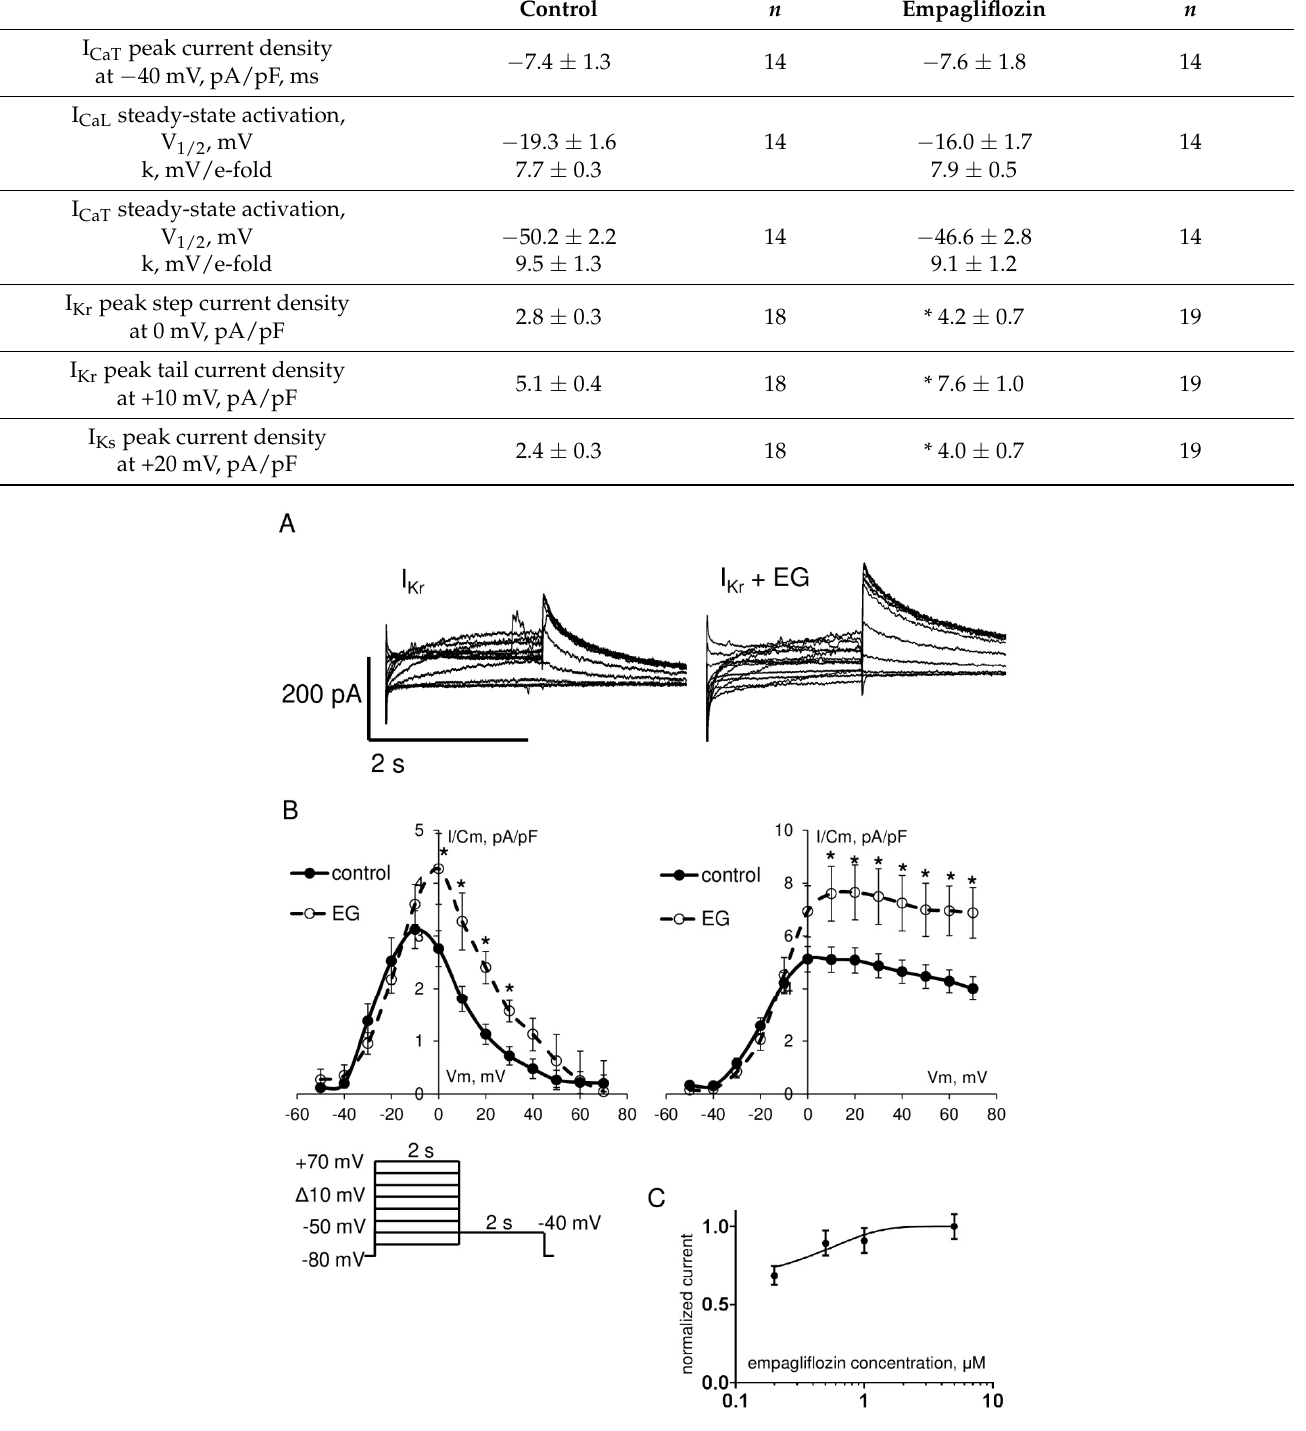
Figure 5. ( A ) Representative whole-cell current traces of I Kr in freshly isolated ventricular cardiomy- ocytes from zebrafish in control (left) and after 2 h incubation with 5 µ M empagliflozin (right). ( B ) The current density–voltage relationship of the I Kr step (left) and tail (right) current in control ( n = 18) and in empagliflozin–treated ( n = 19) cardiomyocytes. * p < 0.05 obtained by Student’s t -test. Voltage clamp protocols used to estimate I Kr are shown at the bottom. ( C ) Concentration–response curve for empagliflozin effect on the I Kr tail current density at +10 mV. The solid line shows least-squares fit to the Hill